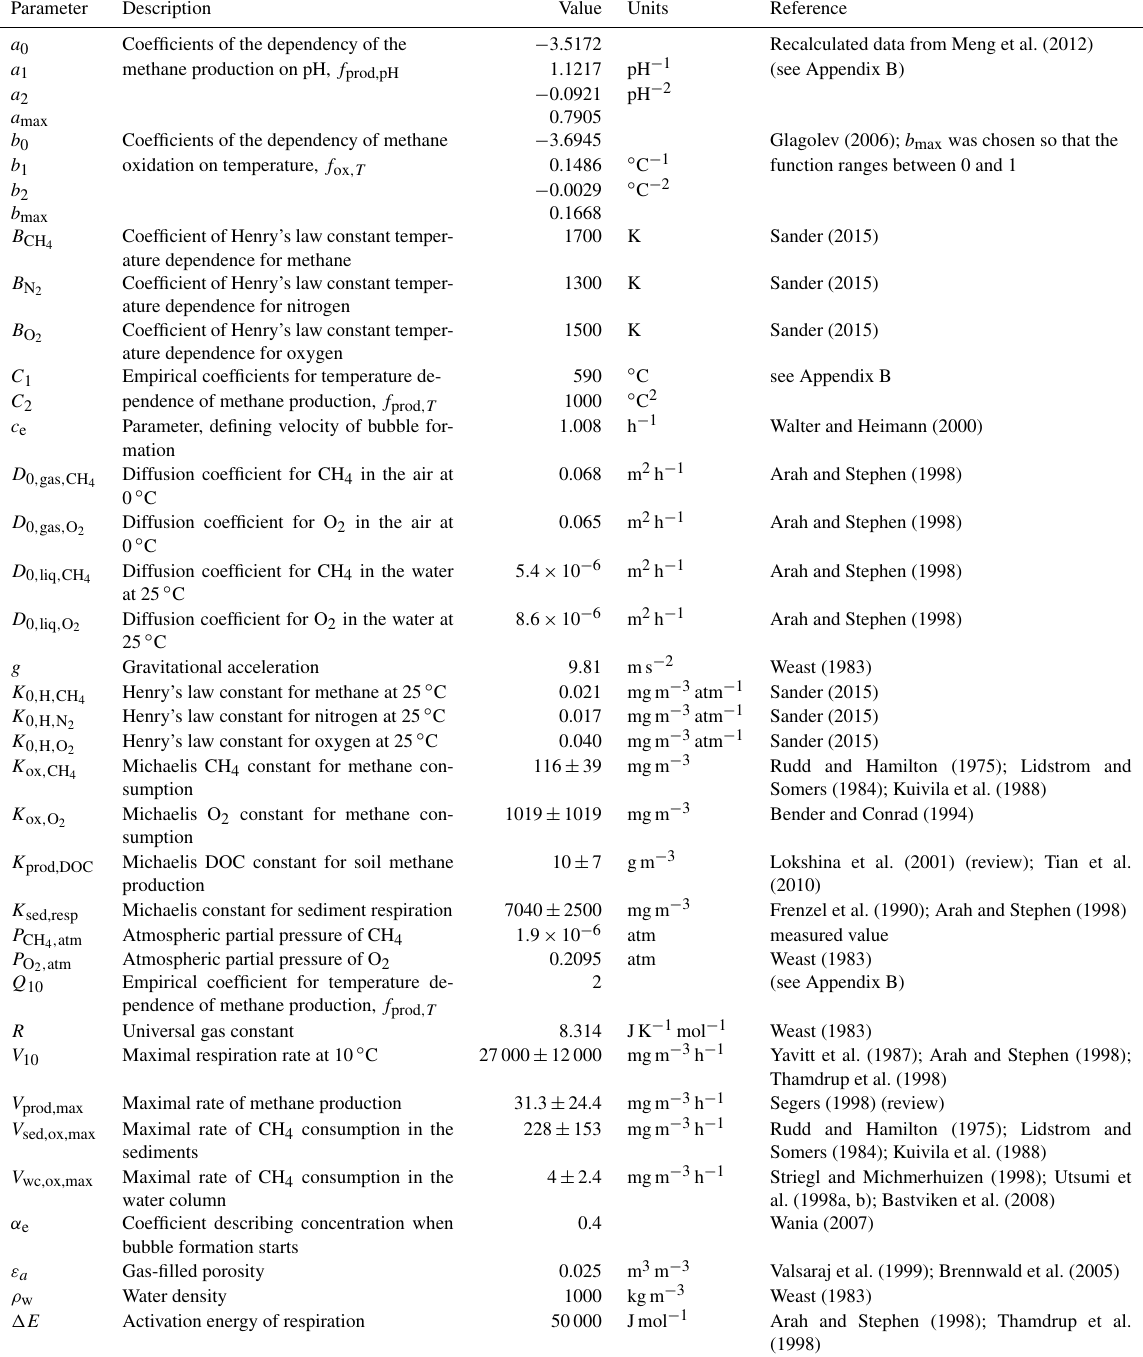
Table A1. List of the model